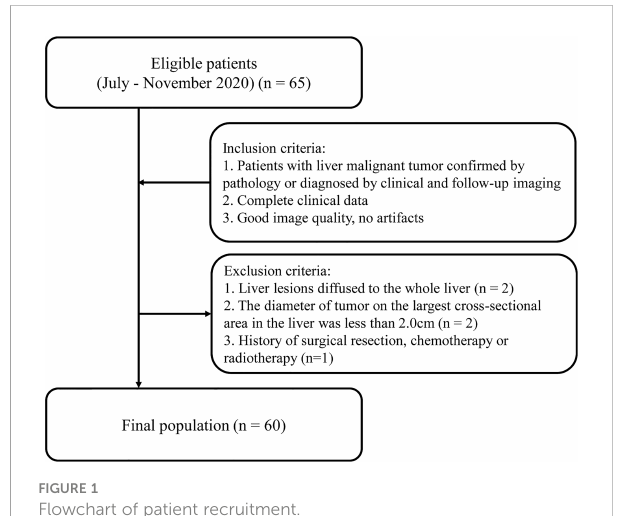
FIGURE 1 Flowchart of patient